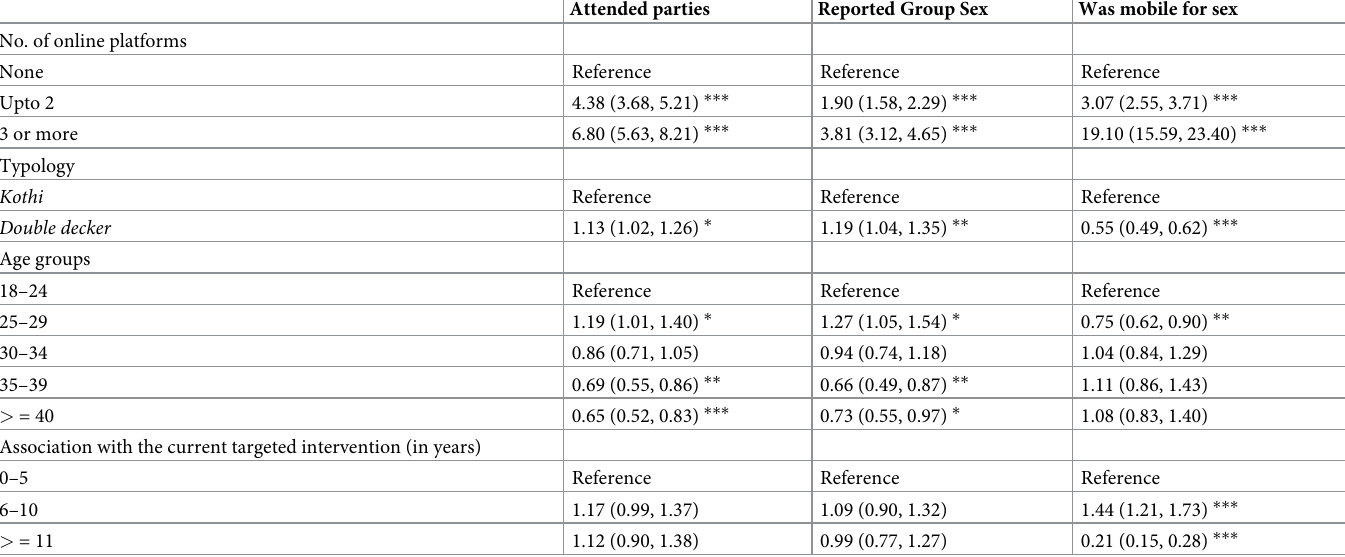
Table 5. Logistic regression models for risk behaviours (attended parties, reported group sex, and were mobile for sex) among 8582 men have sex with men, Mum- bai, India.